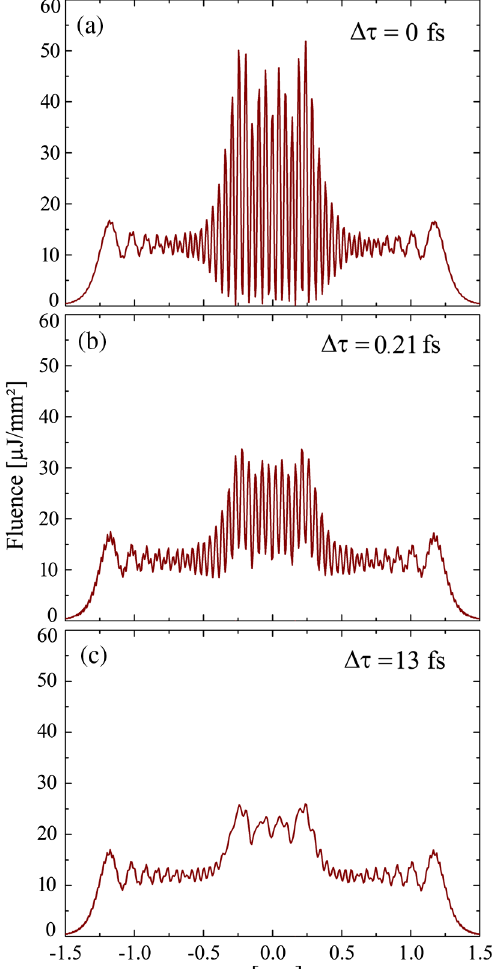
ideal flat mirrors for zero delay (a) for τ ¼ 0 . 21 fs (b) and for τ ¼ 13 fs (c).